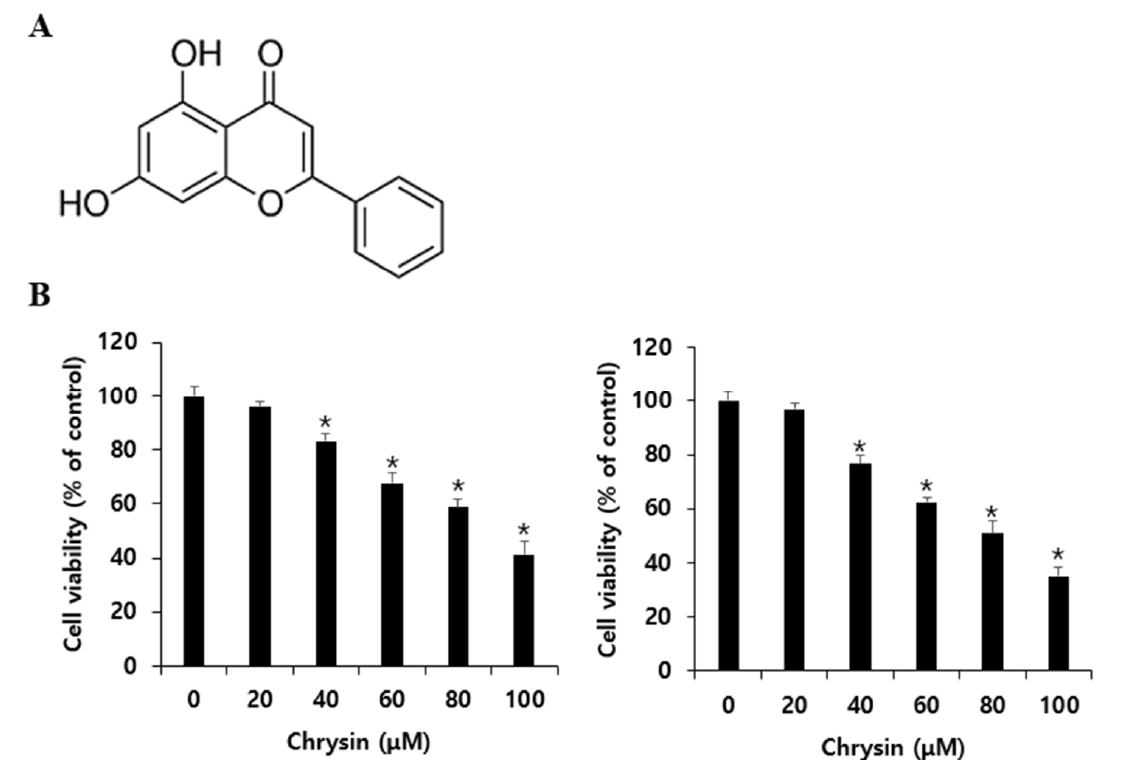
Figure 1. Chrysin inhibits cell viability in A375SM and A375P human melanoma cancer cells. ( A ) Chemical structure of chrysin. ( B ) A375SM and A375P cells were seeded in 96-well plates, incubated for 24 h, and then treated with the indicated concentration of chrysin for 24 h. Cell viability was measured by MTT assay. Data are presented as the mean and standard deviation for three samples. Significance was determined by Student’s t -test, * p < 0.05, compared with the